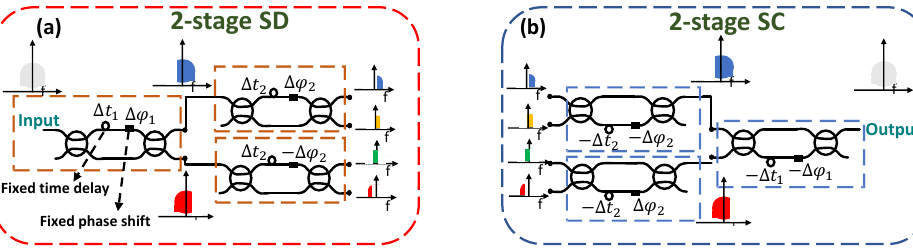
Figure 3. Optical structure to slice the signal into frequency sub-bands ( a ) and reconstruct it ( b